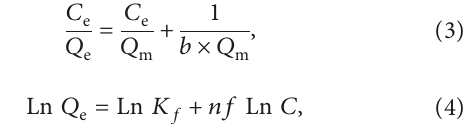
e for adsorption of heavy metals onto ZV4 and